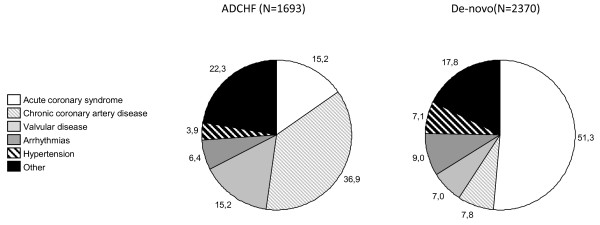
The differences in etiologies between de-novo and acute decompensation of chronic heart failure. ADCHF - Acute decompensation of chronic heart failure, De-novo - Acute heart failure de-novo.